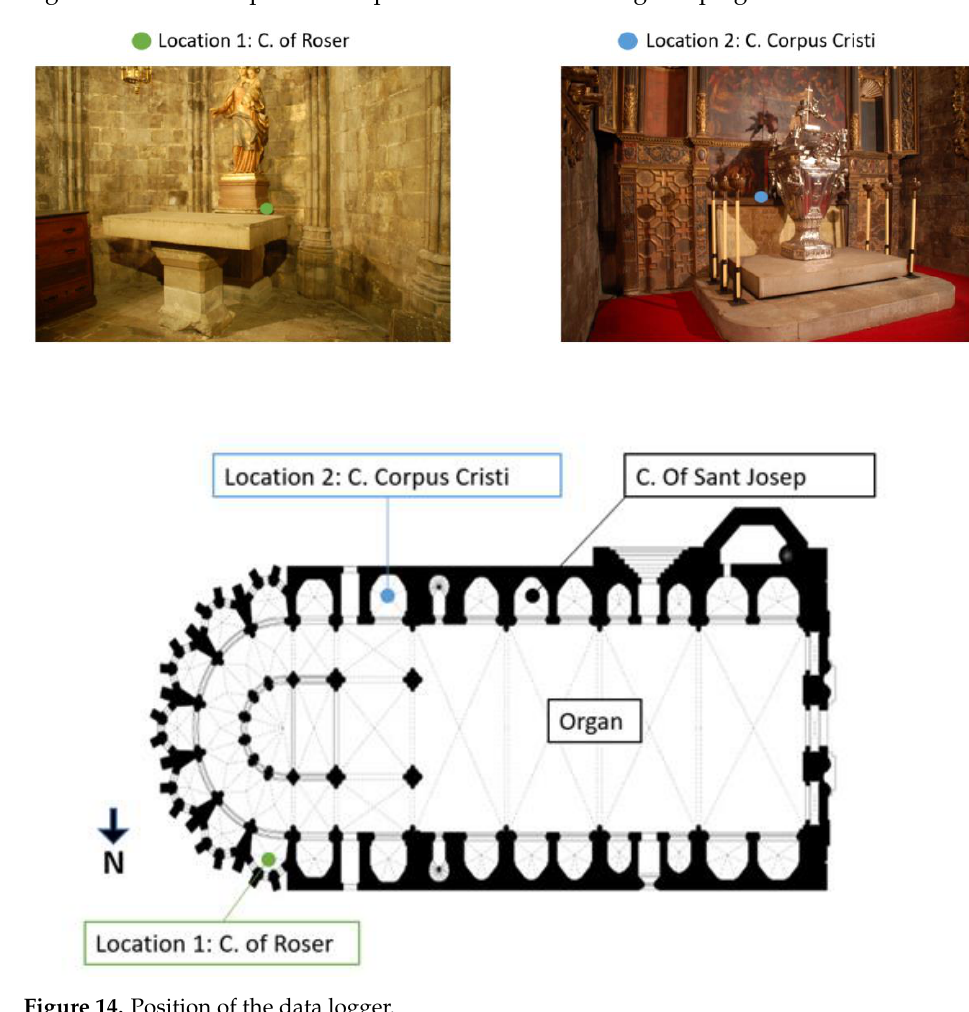
Figure 14. Position of the data logger.